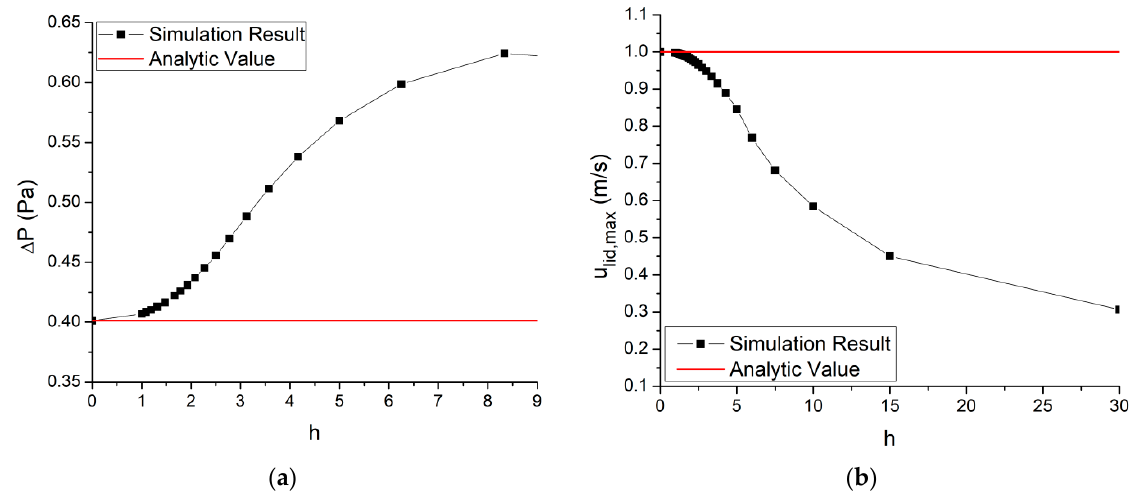
Figure 7. The MMS simulation result that has switching conditions: ( a ) Case 20; ( b ) Case 35.